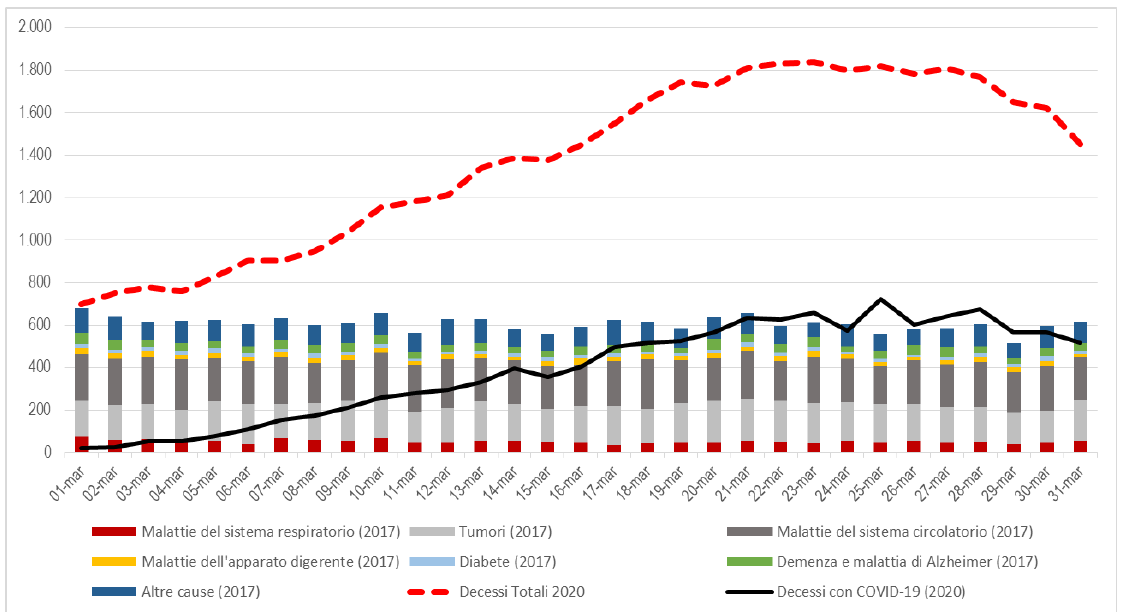
Figura 14. Confronto tra i decessi giornalieri per le principali cause iniziali di morte a marzo 2017 e i decessi con Covid-19 e per tutte le cause a marzo 2020. Area